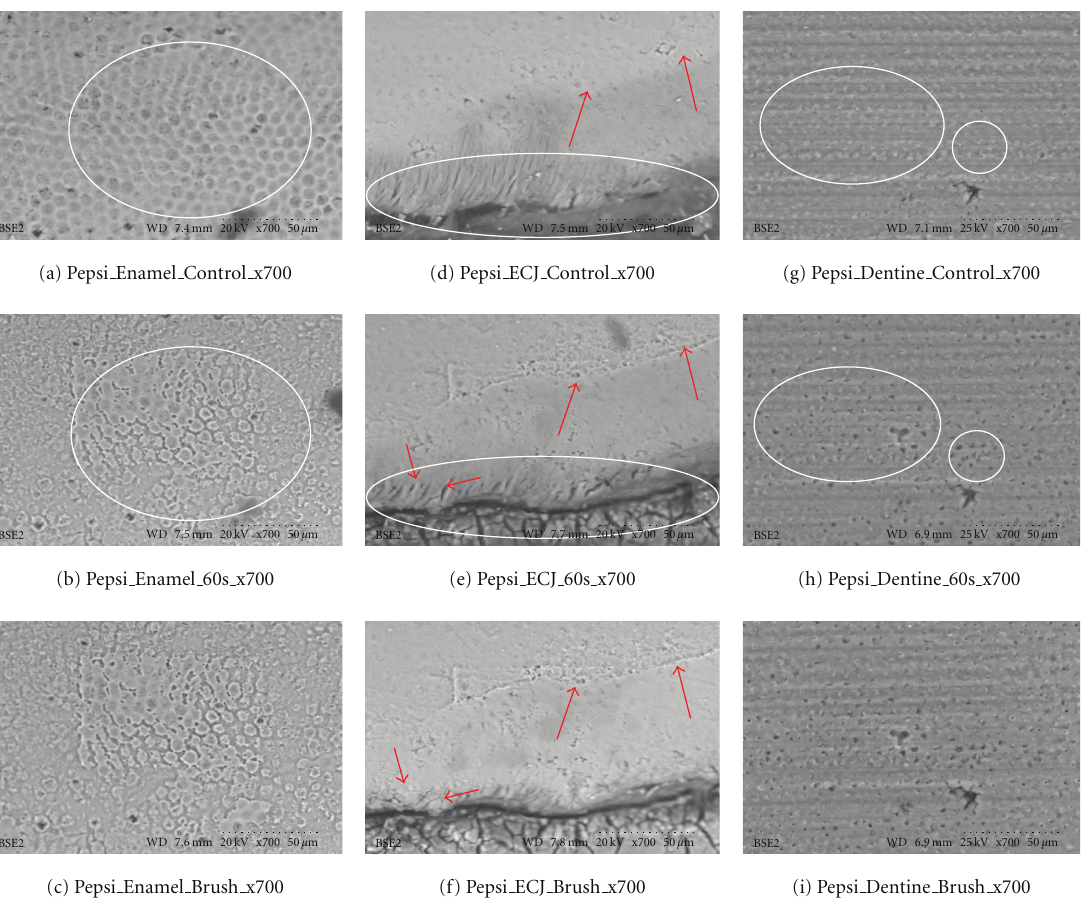
Figure 7: Coca Cola ( × 700). (a–i) White ovoid outlines show erosion in the same areas for enamel, ECJ, and dentine. Red arrows indicate obvious locations of change. There is minimal abrasion in (c), as enamel is dense, hard, and resistant to the brushing. But white outline in (e) shows erosion, and red arrows show loss of surface material from brush abrasion in (f). These SEM results are consistent with the calcium dissolution from swishes in Figure